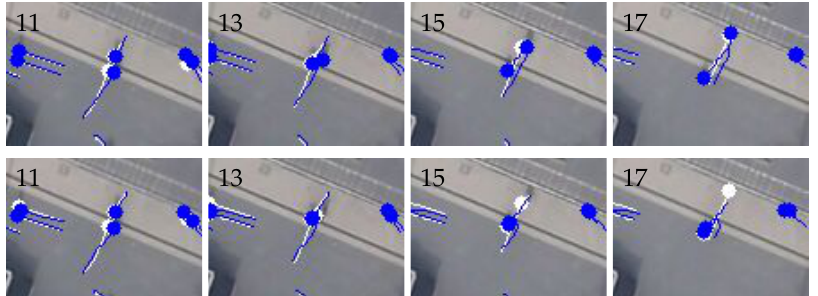
Figure 15. Tracking results by the AerialMPTNet ( top row ) and SMSOT-CNN ( bottom row ) on the frames 11, 13, 15, and 17 of the “Pasing8” sequence of the AerialMPT dataset. The predictions and ground truth are depicted in blue and white, respectively.